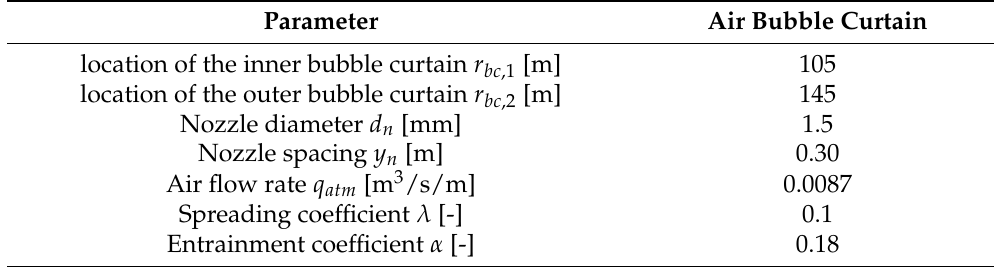
Table 4. Basic input parameters of the air bubble curtain